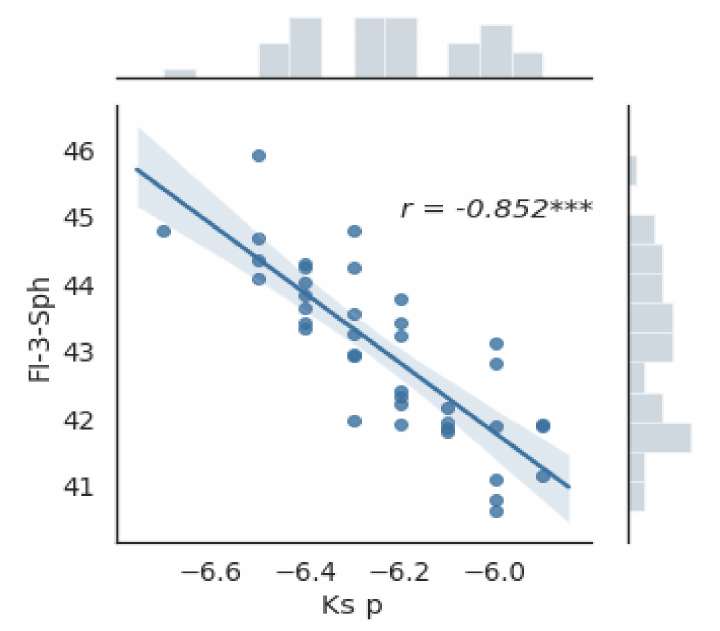
Figure 3. Graph of the relationship between the value of the corneal spherical refractive power component (Fi-3-sph) and the steep meridian of the keratometry of the posterior surface of the cornea. Correlation coefficient r = − 0.852; p < 0.0001; *** p <